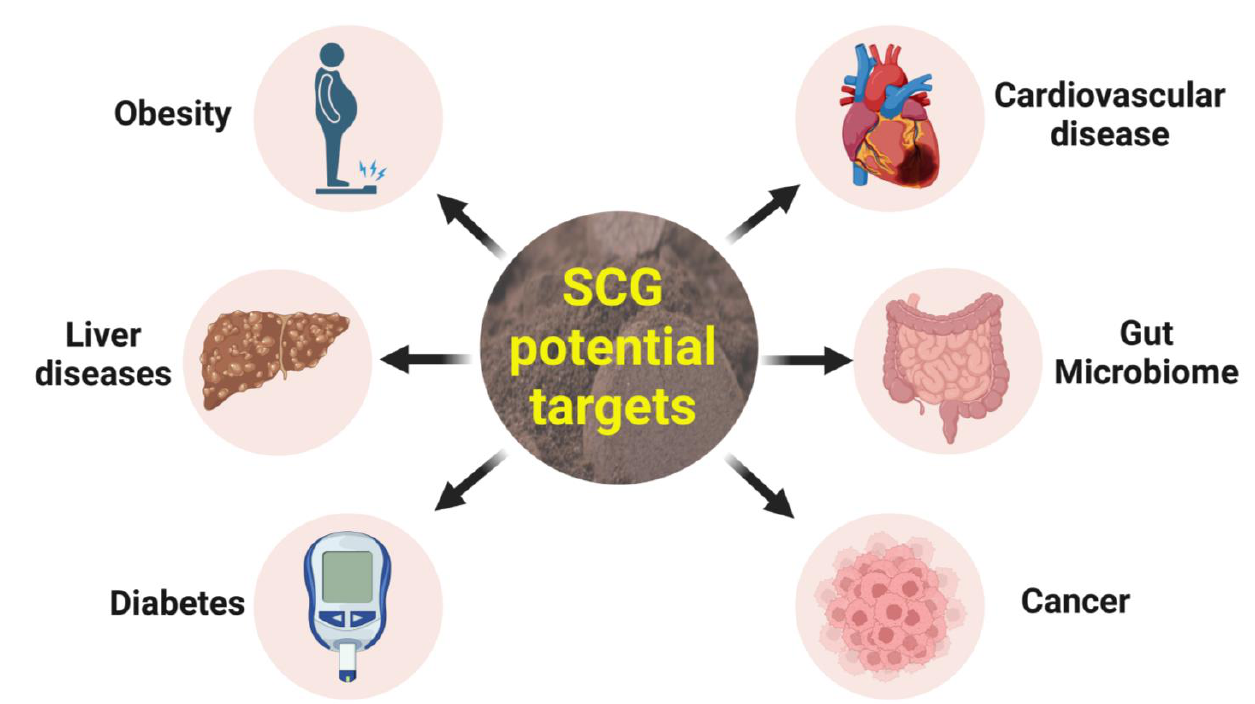
Figure 3. Potential health benefits of spent coffee grounds.